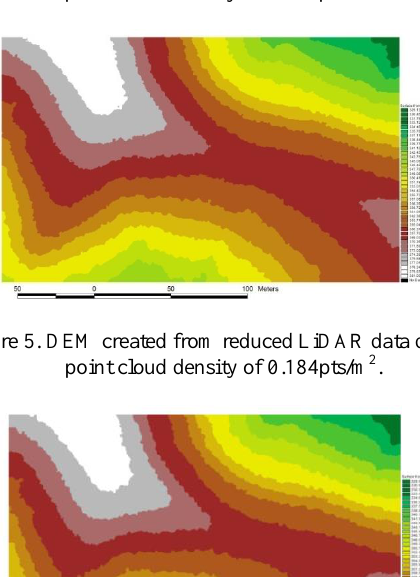
Figure 4. DEM created from reduced LiDAR data down to point cloud density of 0.222pts/m 2 .